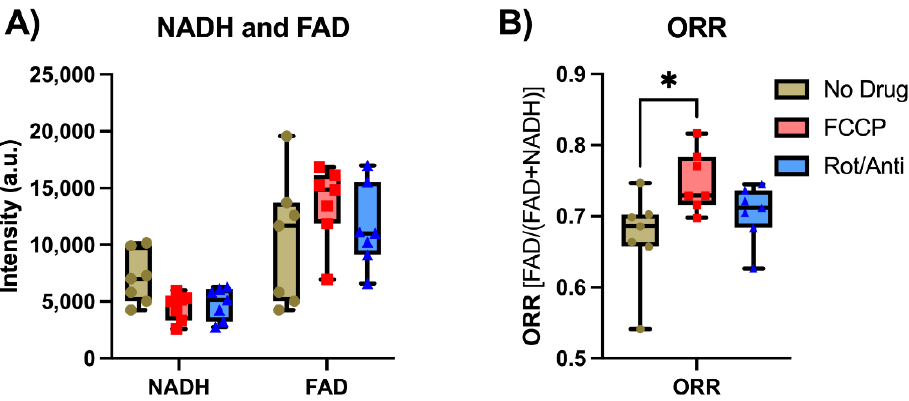
Figure 6. Box plots of endoscope data from tumor pieces under metabolic modulation ex vivo. ( A ) Modulation data for the NADH and FAD channels: ( B ) The calculated ORR. No drug is when the malignant tumor pieces were imaged after being placed in 8 mM glucose. FCCP is when endoscope images were taken after tumor pieces were submerged in a 50 µM FCCP/8 mM glucose solution. Rot/Anti represents when the pieces were imaged after being submerged in a solution with 50 µM rotenone, 20 µM antimycin A, and 8 mM glucose solution. All tumor pieces ( n = 7) were imaged after being in their respective solutions for five minutes. (* = [0.05 ≥ p > 0.01]).